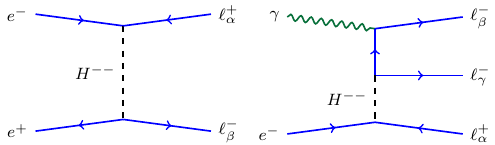
Figure 8. Feynman diagrams for off-shell production of H ±± at future lepton colliders (cf. the processes in Equation (6)). Figure from Ref. [58].